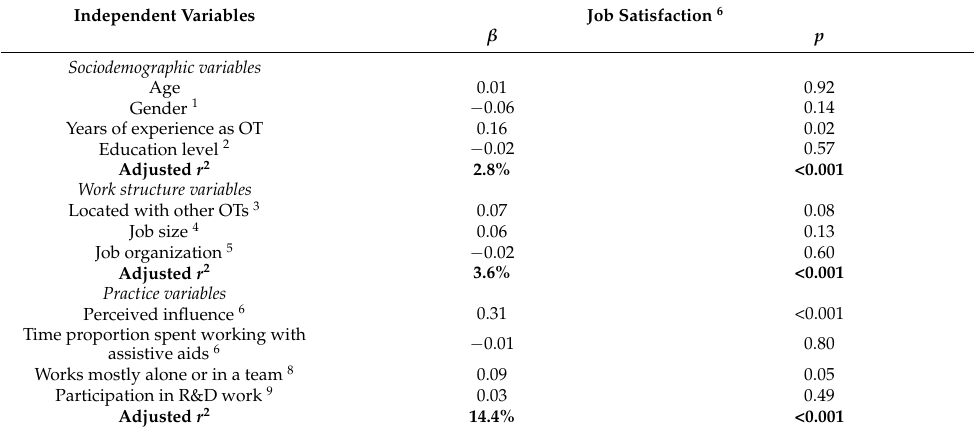
Table 3. Hierarchical linear regression analysis displaying adjusted associations between independent variables and job satisfaction (JSS